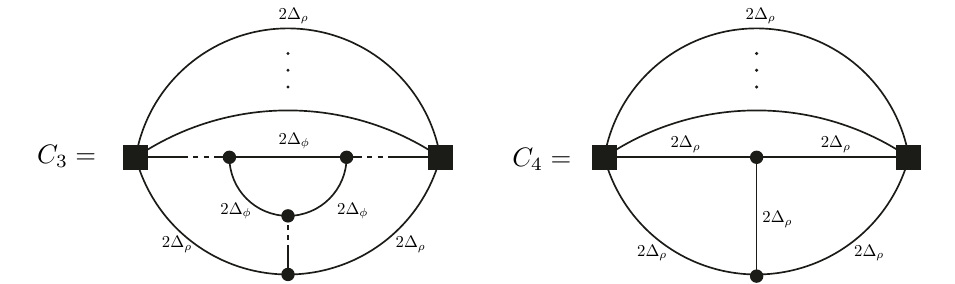
Figure 6 . Finite diagrams which contribute to the full correlator black squares denote insertions of the composite operator ρ n . All propagators are propagators of ρ , (2.6).